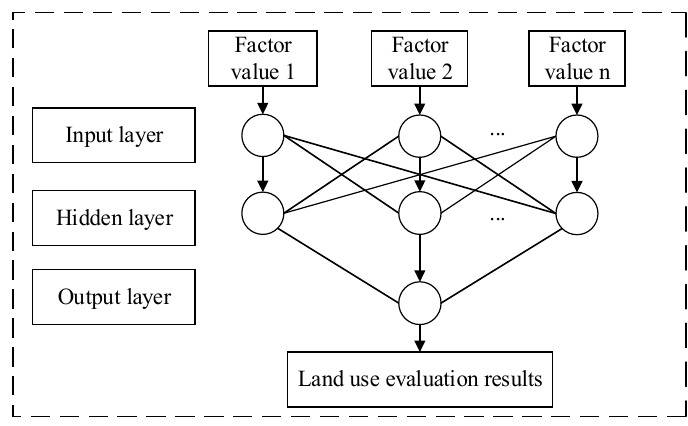
Figure 3. Composition and structure of the deep BPNN land evaluation model .